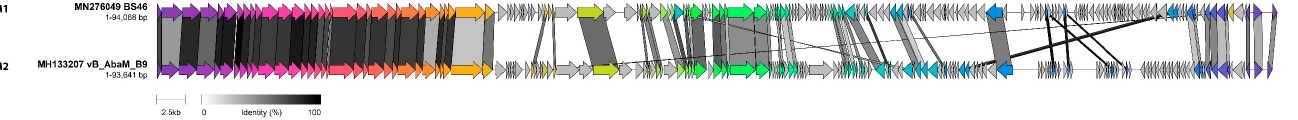
Figure 13. Comparative genome alignment of phages BS46 and B9. Phage genomes are presented alongside their designated sub-cluster, accession number, name and genome length. Coding sequences are represented by arrows, coloured to reflect homologous groups identified by Clinker, and are linked by grey bars shaded to represent the percentage amino acid identity, as indicated in the legend.